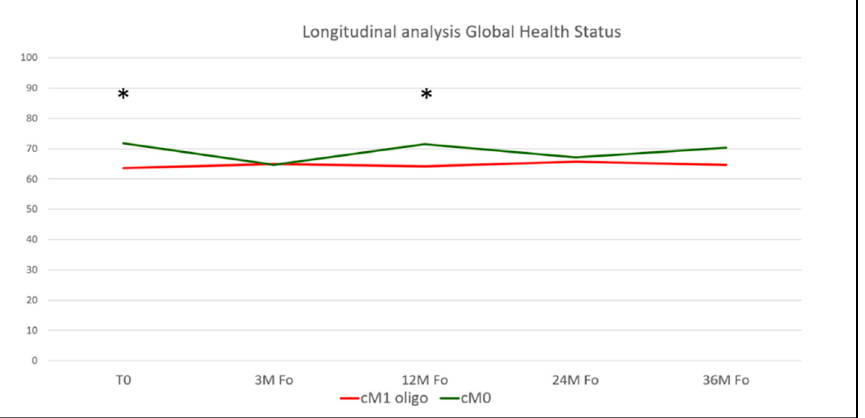
Figure 3. Longitudinal analysis of postoperative patient-reported Global Health Status, assessed by the validated EORTC QLQ-C30 questionnaire. Asterisks indicate p -values < 0.05 and were considered statistically significant. EORTC-QLQ-C30: European Organization for Research and Treatment of Cancer quality of life questionnaire-Cancer 30.